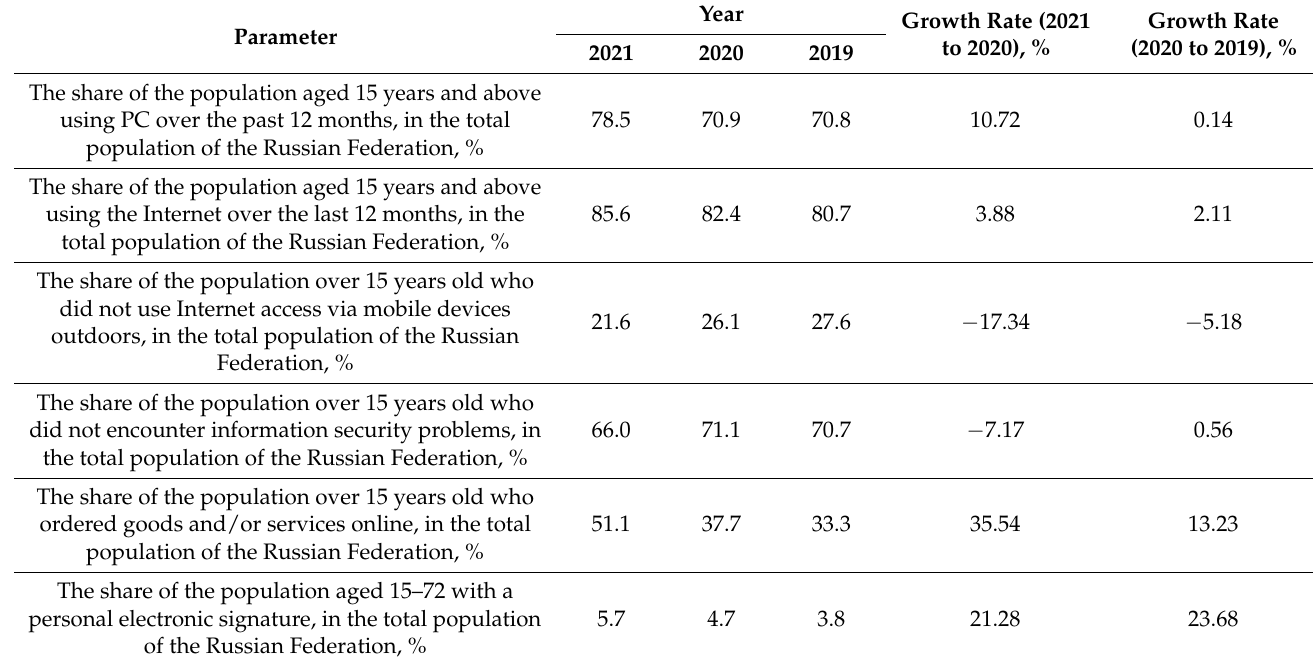
Table 2. Statistics on information technologies and information and telecommunication networks usage by the